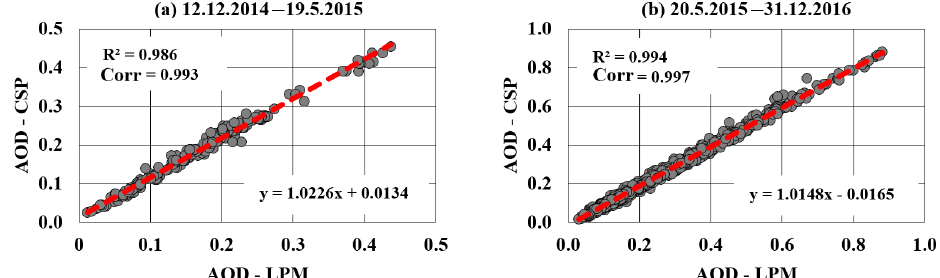
Figure 7. Comparison of AOD values for the wavelength of 320nm obtained by means of the LPM and the Cimel sun photometer (CSP).